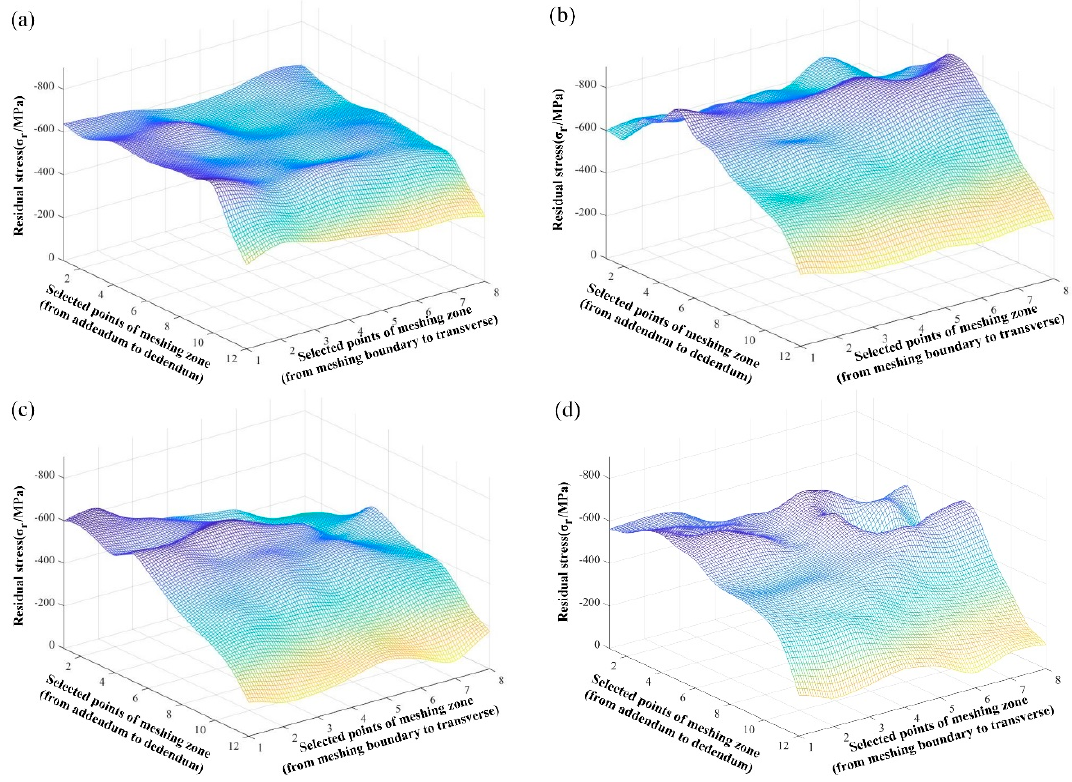
Figure 13. Fitting flanks of residual stress value: ( a ) gear 1 ‐ 2, ( b ) gear 2 ‐ 2, ( c ) gear 3 ‐ 2, and ( d ) gear 4 ‐ 2.